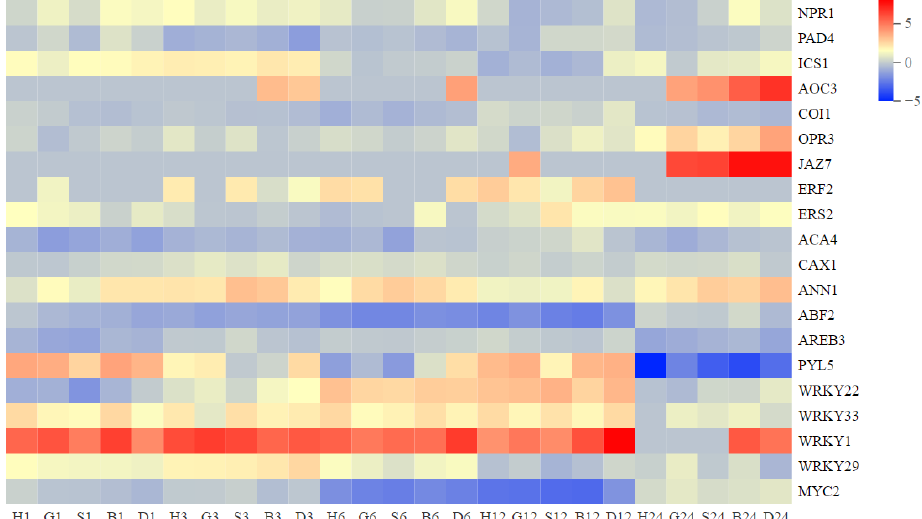
Figure 8. Typical resistance genes response to spraying treatments at 1, 3, 6, 12, and 24 h. Heat map represents the value of DEGs as L2FC relative to CK (0 h) (H, H 2 O treatment; G, GSH treatment; S, GSSG treatment; B, BSO treatment; D, DTT treatment).